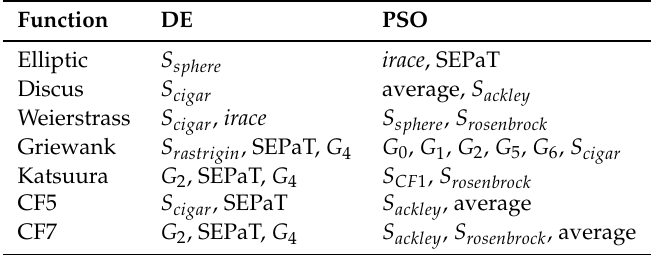
Table 9. Best-performing DE and PSO configurations on the seven test functions.